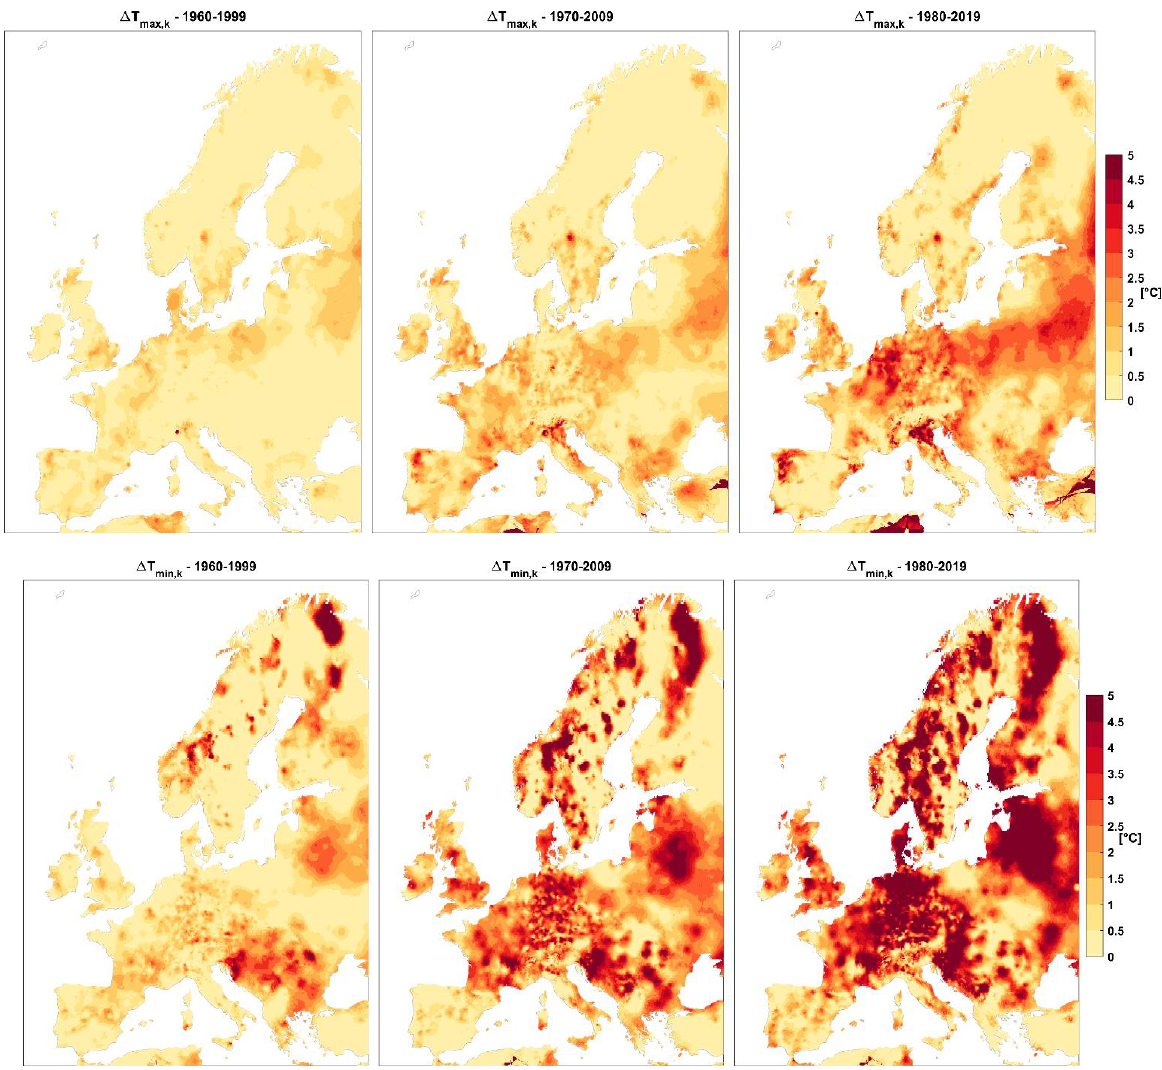
Remote Sens. 2021 , 13 , x FOR PEER REVIEW 15 of 26 Figure 7. Delta change maps of characteristic values of daily temperatures (cid:1846) (cid:2923)(cid:2911)(cid:2934) and (cid:1846) (cid:2923)(cid:2919)(cid:2924) , based on the E-OBS dataset. Figure 7. Delta change maps of characteristic values of daily temperatures T max and T min , based on the E-OBS dataset.